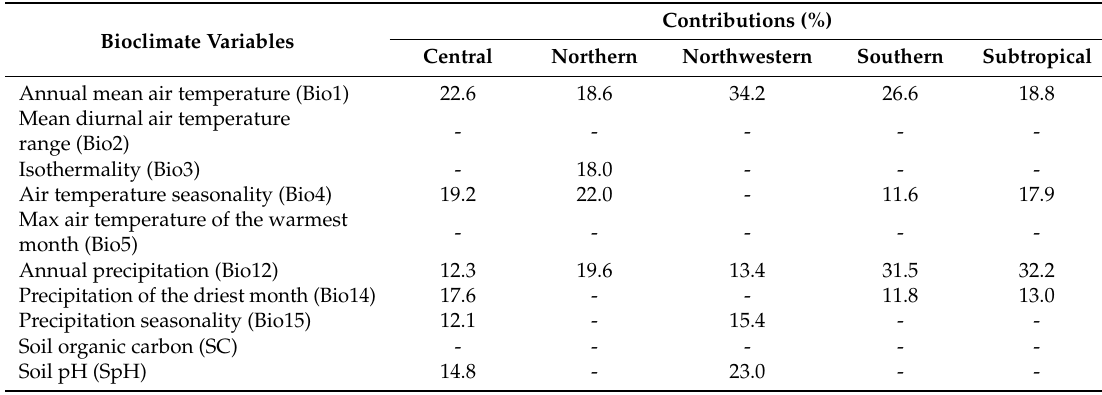
Table 2. Contributions of the major environmental parameters in the MaxEnt models for the five seed zones of Platycladus orientalis